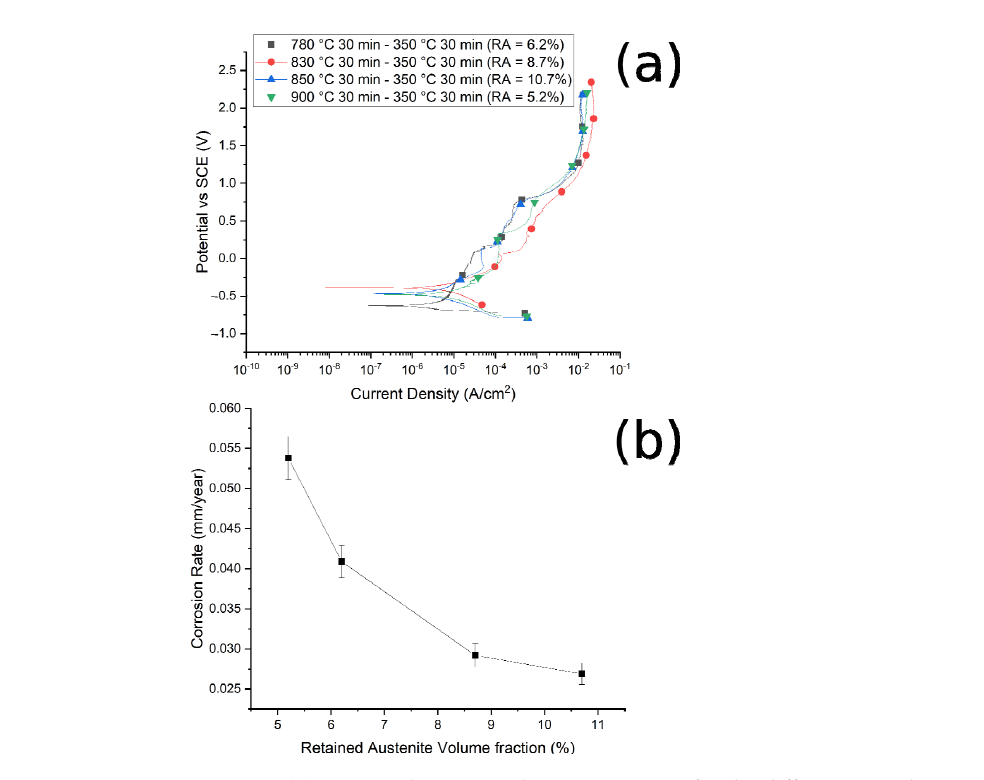
Figure 10. ( a ) Potentiodynamic polarization curves for the different samples austenitized at 780 °C, 830 °C, 850 °C, 900 °C and austempered at 350 °C. ( b ) Correlation between corrosion rate and RA volume fraction. Test performed in borate buffer solution.